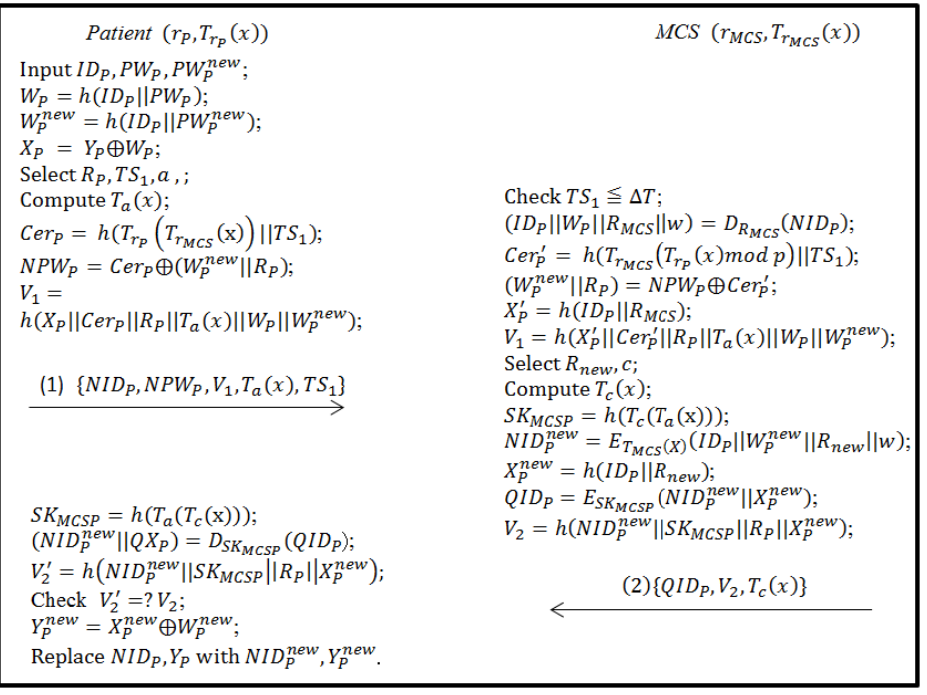
Figure 6. The processes of password-updating phase of the proposed